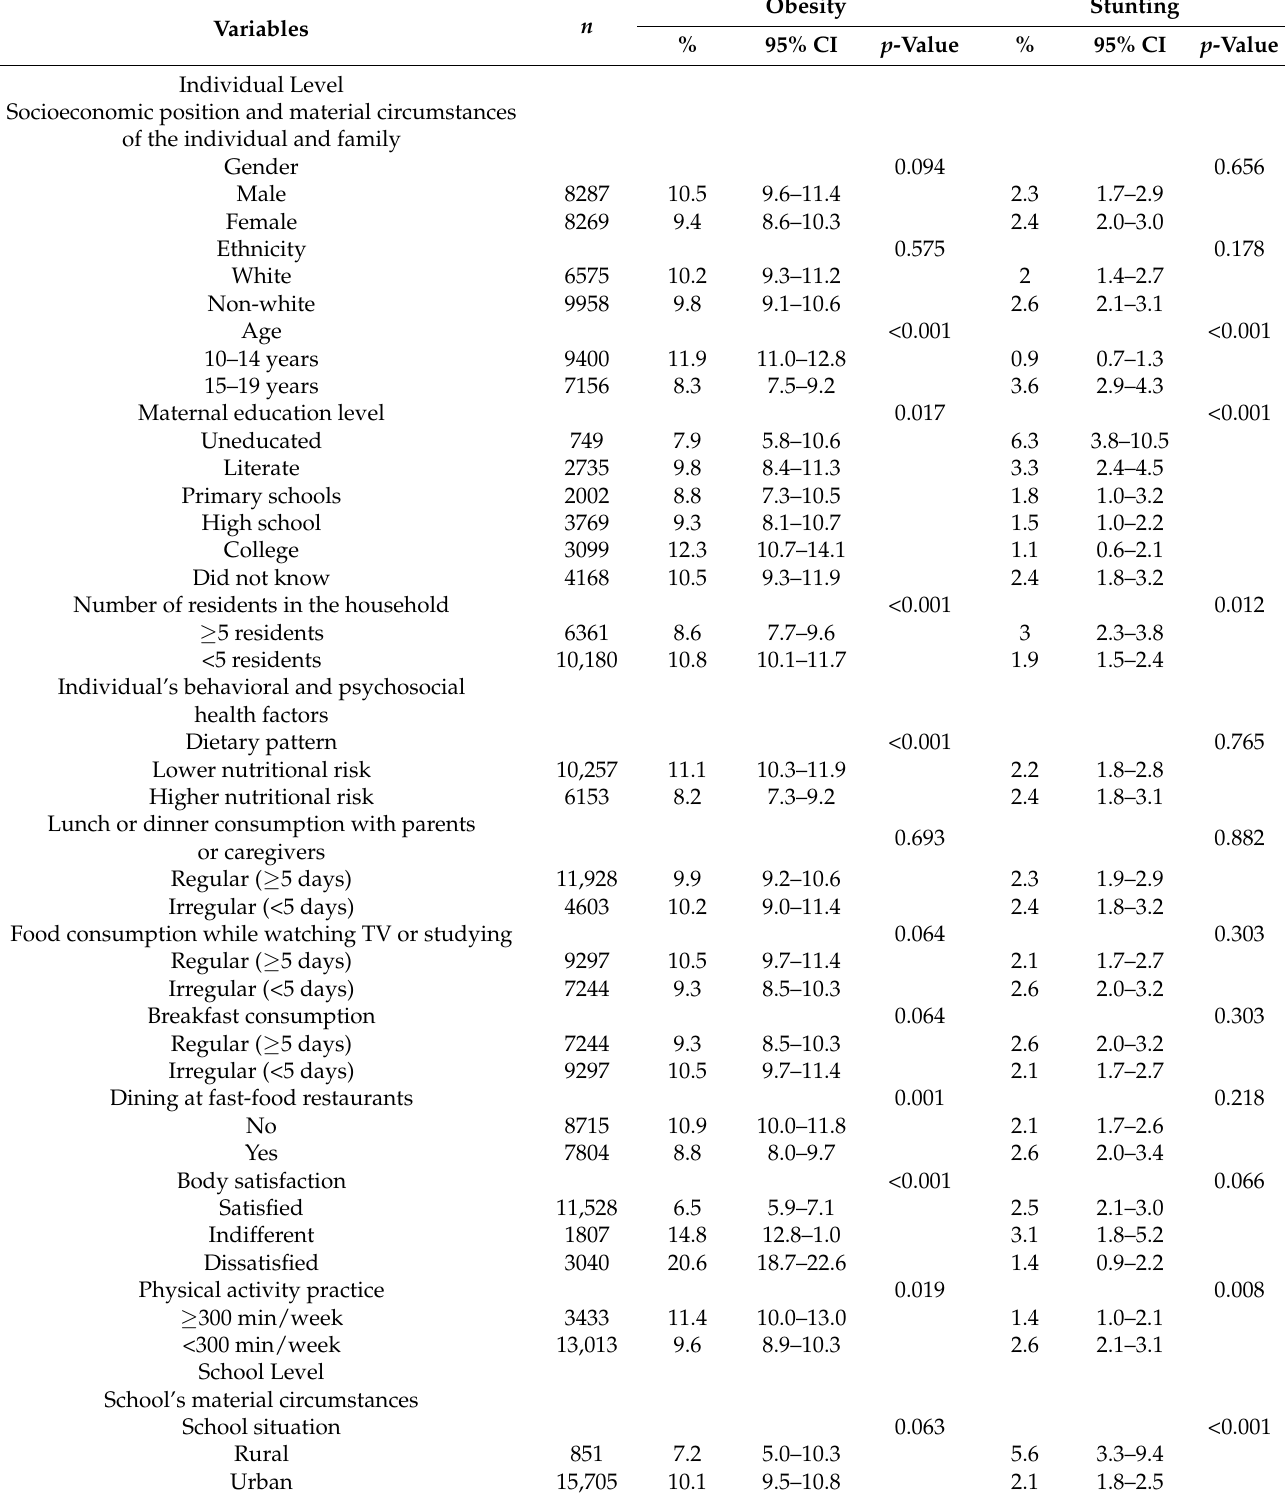
Table 1. Distribution of obesity and stunting prevalence among Brazilian adolescents and individual- and school-level variables, National School Health Survey,